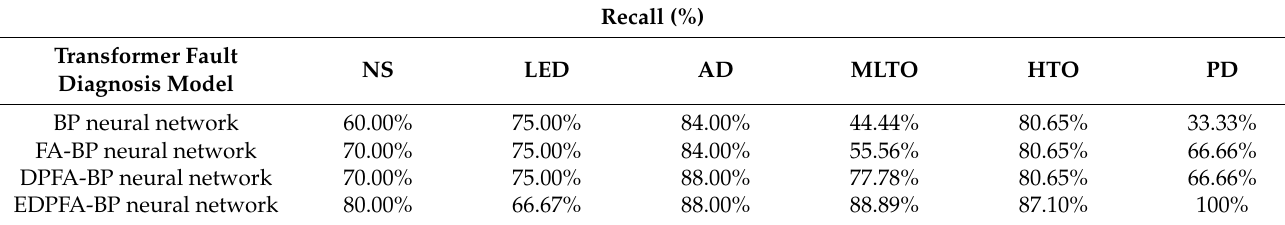
Figure 9. The diagnosis results from the four models. Table 8. The accuracy of each model. Table 9. The recall of each model.